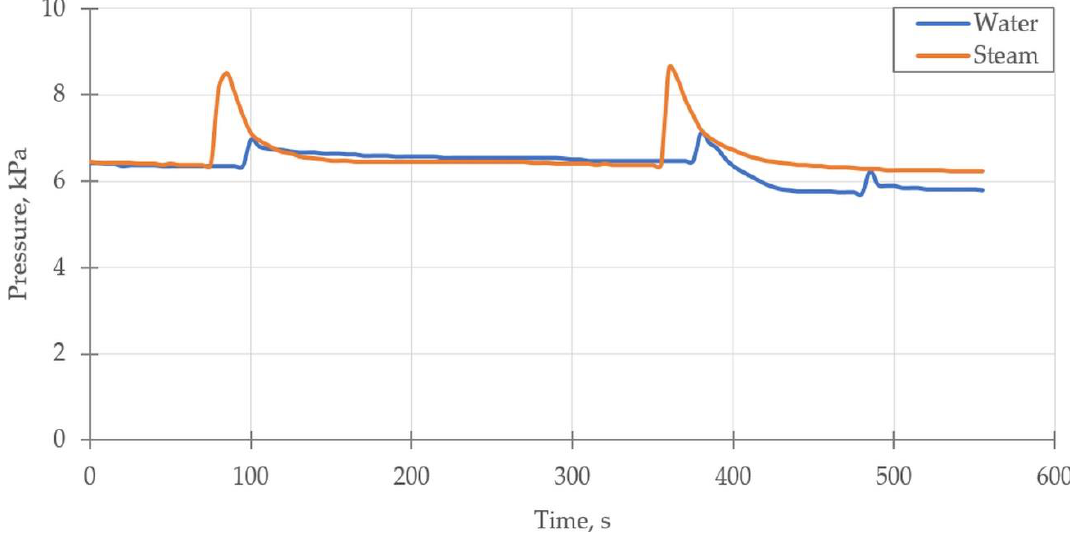
Figure 9. Pressure inside the condenser (P4). Figure 8. Temperature of the water vapor leaving the bed and flowing to the condenser (T10).